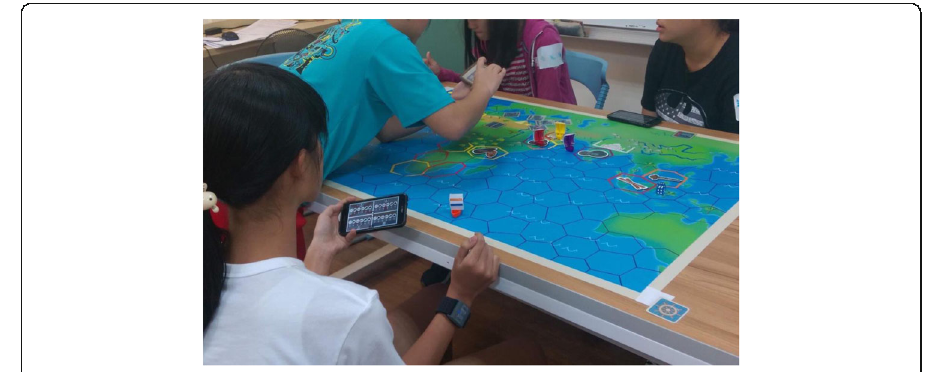
Fig. 5 Great Voyage board game in